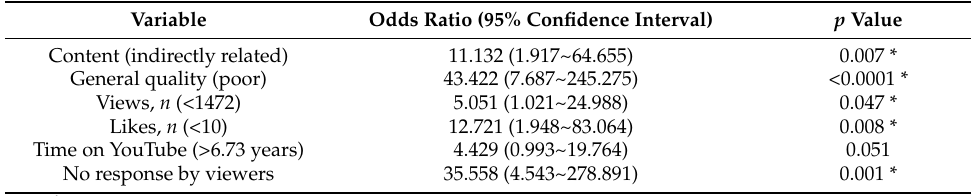
Table 6. Correlating factors of low-quality videos (score < 5